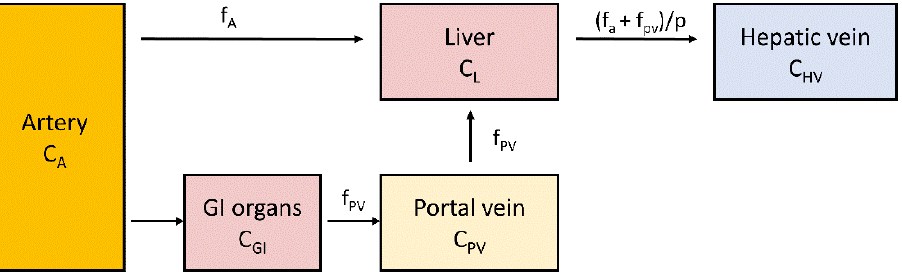
Figure 3. Schematic representation of a single compartment model of liver perfusion. C A , C GI , C PV , C L and C HV represent 15 O-H 2 O concentrations in arterial, gastrointestinal, portal vein, liver and hepatic vein compartments: f A represents perfusion from the artery, and f PV represents portal vein perfusion; p is the partition coefficient of water in the tissue. Tracer concentration in portal vein can be measured either directly or derived from arterial input by taking into account delay and dispersion caused by blood passing through gastrointestinal organs [90,91].